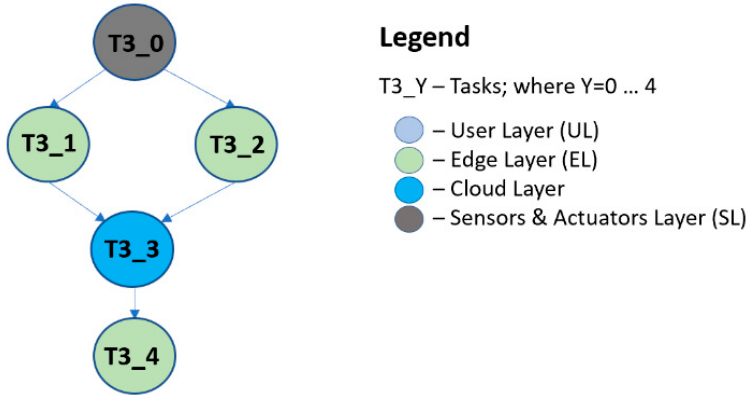
Figure 6. Task graph for the problem of collecting/updating data on weather conditions.